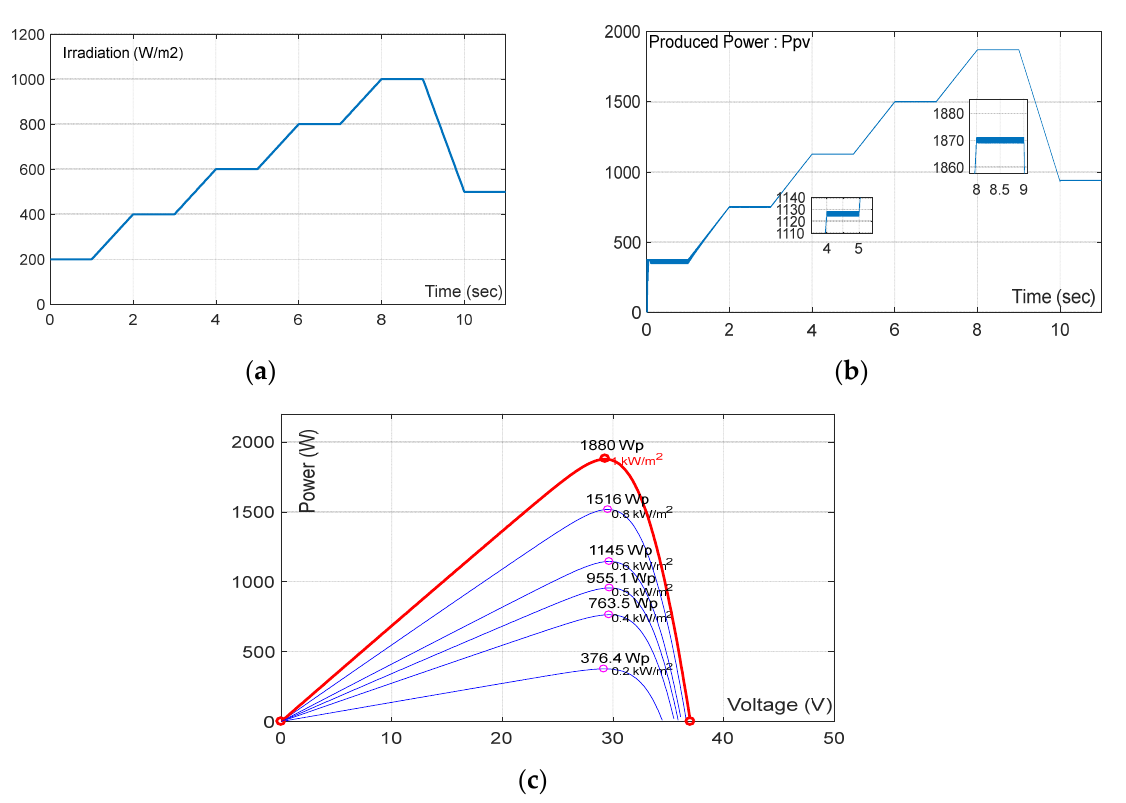
Figure 11. ( a ) Irradiation profile (W/m 2 ), ( b ) produced power P pv and, ( c ) P pv - V pv characteristic. The evolution of the produced power is illustrated by Figure 11b. This figure demon- strates that the produced power converges to the actual power, thanks to good perfor- mances of the VSS-P&O MPPT algorithm, which are archived in Table 5. The average efficiency ( P out / P max ) is calculated utilizing the maximum power that can be produced by the PV generator, as depicted in Figure 11c. Table 5. Efficiency obtained for VSS-P&O MPPT technique under different operating conditions. Time